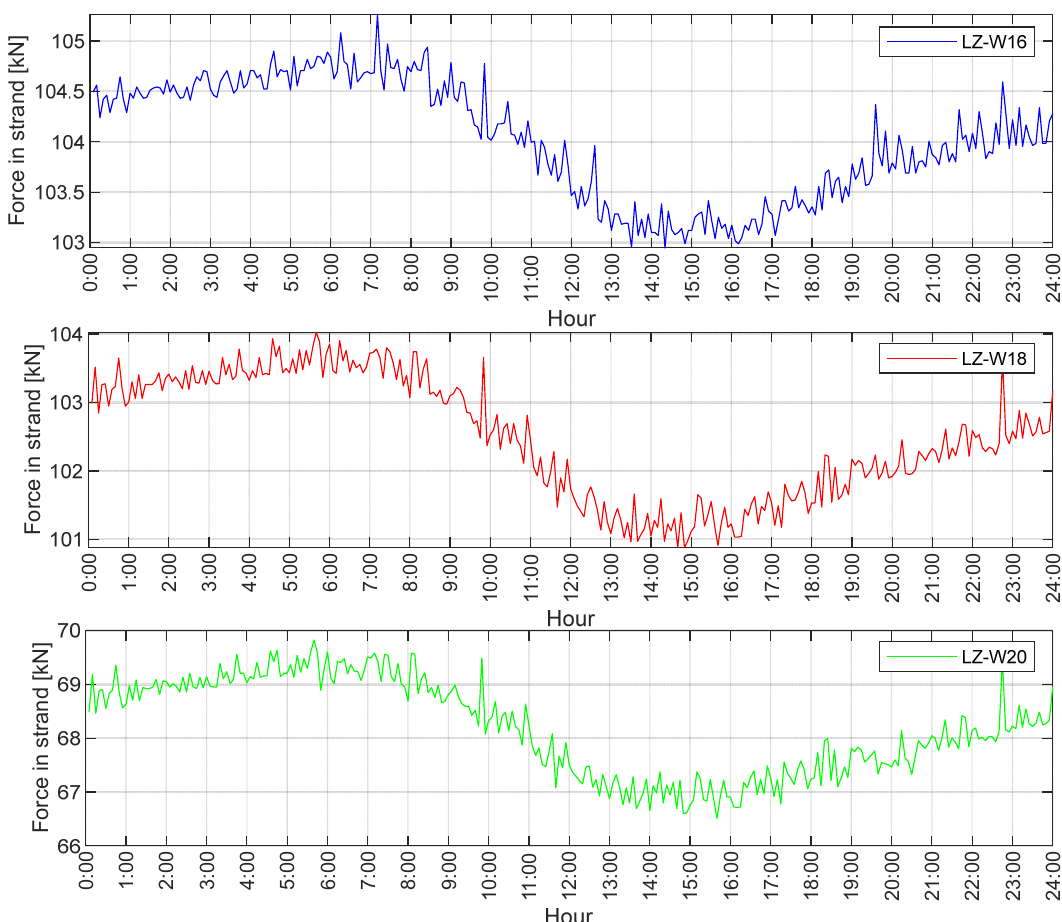
Figure 10. Daily force course in single strands of cables LZ-W16, LZ-W18 and LZ-W20 (1 August 2017).